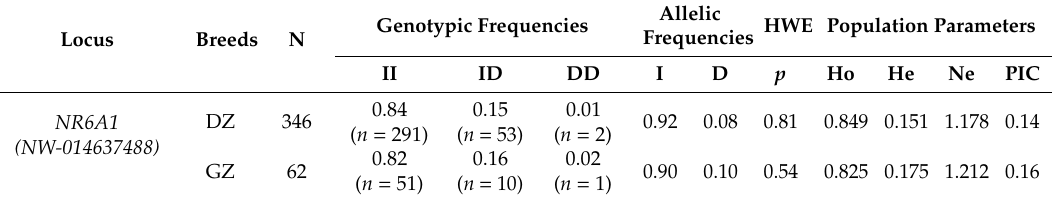
Table 1. Genotypic and allelic frequencies, gene heterozygosity (He), e ff ective allele numbers (Ne), polymorphism information content (PIC) and Hardy–Weinberg equilibrium in the 13 bp deletion locus of the donkey NR6A1 gene. Allelic HWE Population Parameters Genotypic Frequencies Frequencies Locus Breeds N